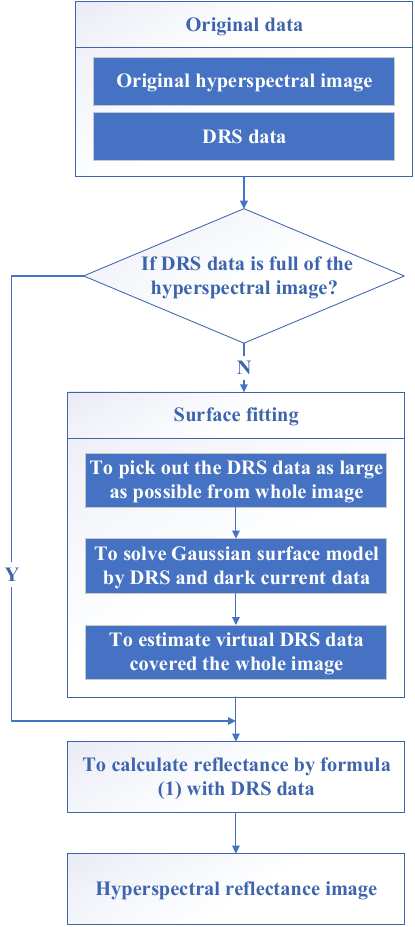
Figure 3 Flow chart of Gaussian surface fitting calibration Step 3. The surface model is used to estimate a virtual DRS data as 𝑹 𝒘𝒉𝒊𝒕𝒆 that will cover the whole hyperspectral image. Step 4. The reflectance of hyperspectral image is corrected by using formula (1), point by point and band by band.